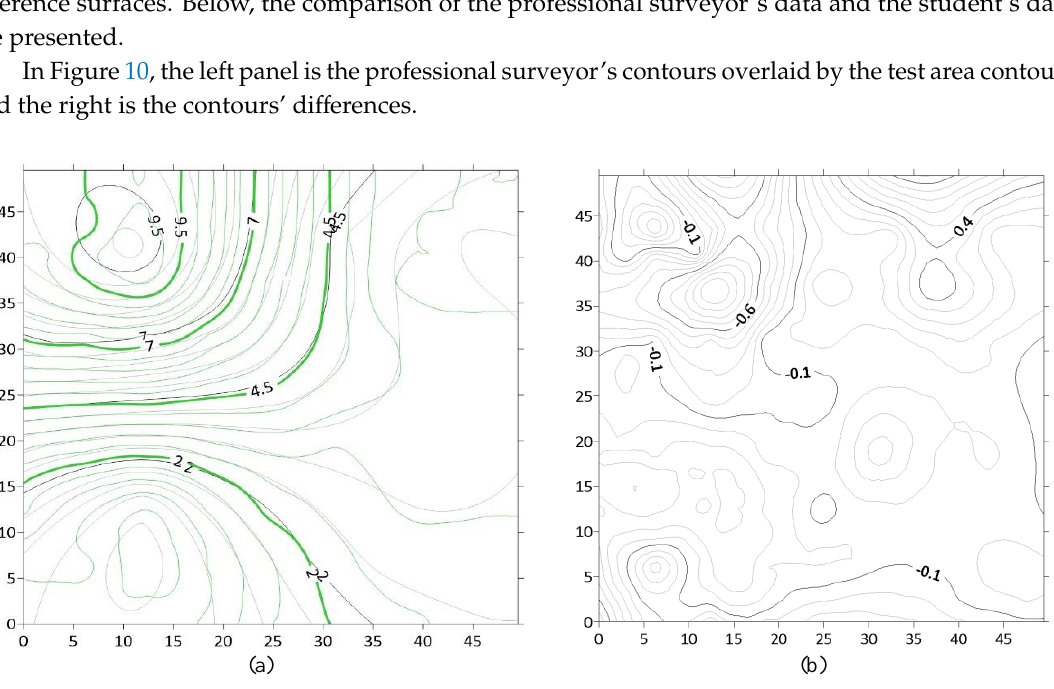
Figure 10. Contours ( a ) and volumetric surfaces ( b ) visual comparison between the reference test area and the surveyor’s data.